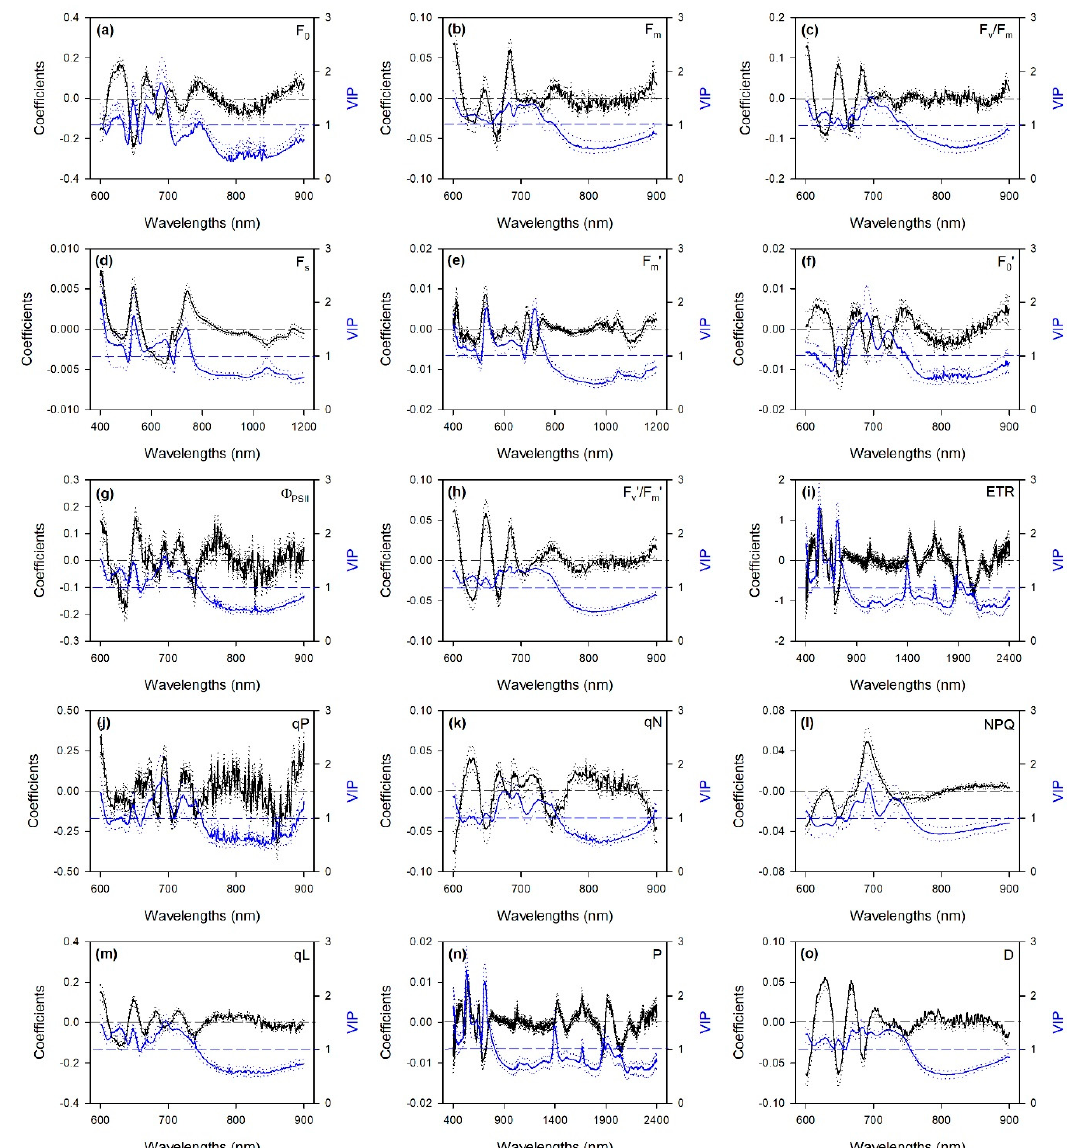
Figure 2. Mean (solid), 5 th and 95 th percentile (dotted) of standardized coefficients (black) and variable importance for projection (VIP, blue) by wavelengths for the PLSR models predicting chlorophyll a fluorescence parameters in date palm leaves. ( a ) F 0 ; ( b ) F m ; ( c ) F v /F m ; ( d ) F s ; ( e ) F m ’; ( f ) F 0 ′ ; ( g ) Φ PSII ; ( h ) F v ’/F m ’; ( i ) ETR; ( j ) qP; ( k ) qN; ( l ) NPQ; ( m ) qL ; ( n ) P; ( o ) D. See Table 1 caption for parameter abbreviations.